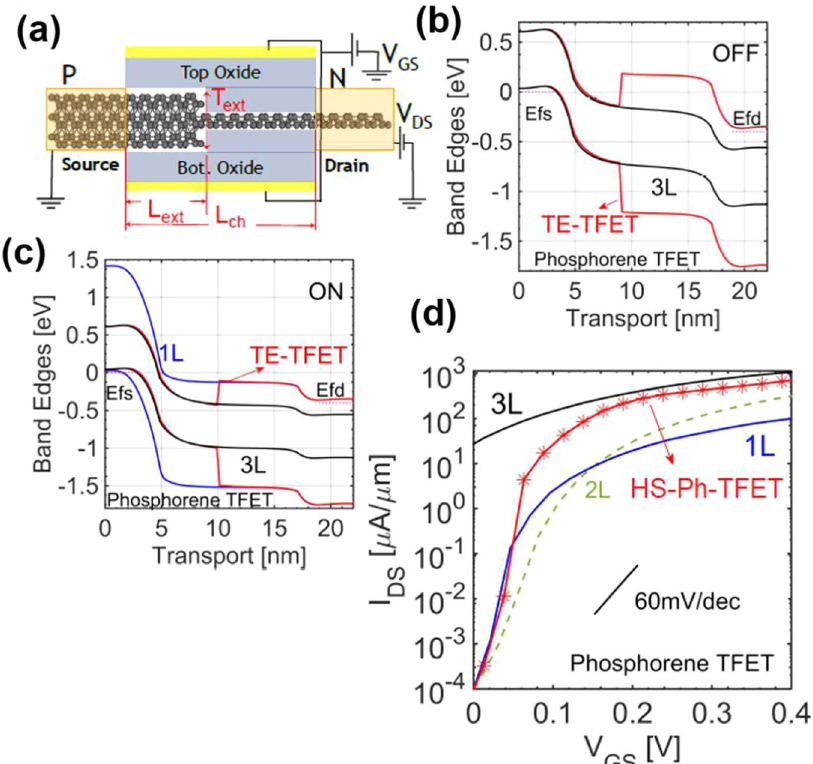
Fig. 18 Simulation Report of Nanoscale Ph-TFET. a Schematics, energy band diagrams in a off-state and c on-state, and d I – V characteristics of hetero-structure Ph-TFET, adapted with permission from 100 . Copyright (2016)